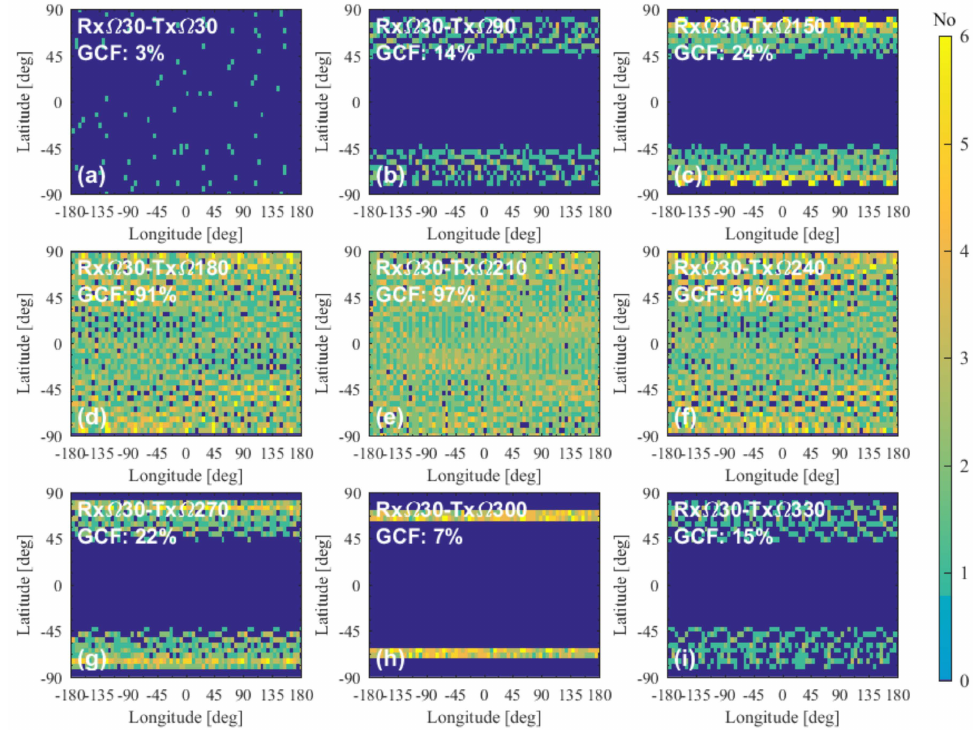
Figure 5. The global coverage of LEO-LEO occultation events for representative polar orbit constel- lations composed of a Rx satellite and a Tx satellite with particular orbital RAANs, illustrating the occultation numbers per 5 ◦ × 5 ◦ latitude and longitude grid cell, while the GCFs were calculated using grid cell areas according to Equation (12).